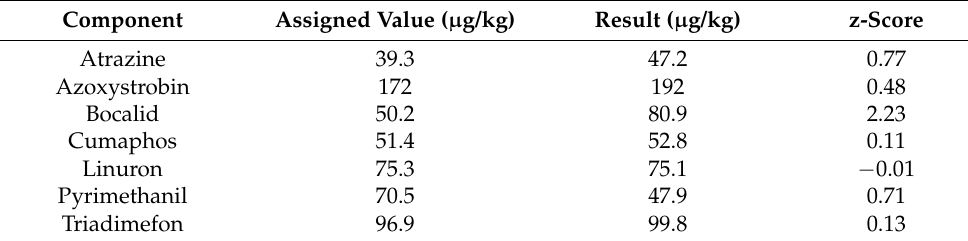
Table 5. Lettuce, proficiency test VF1700P (Test Veritas), October 2021.